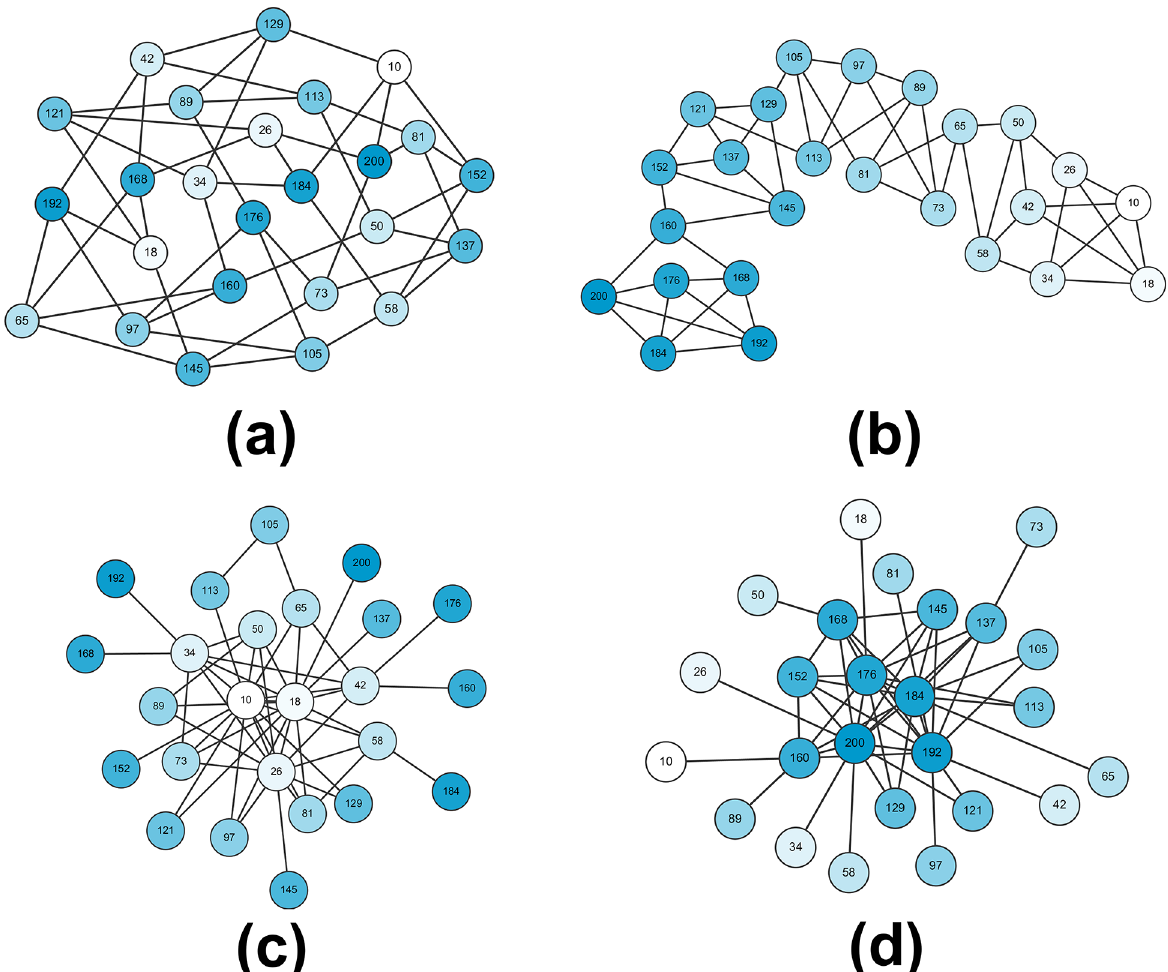
Fig 1. The four network topologies. (a) Lattice_Hetero: actors with discrepant income levels are linked in a lattice, where each node has the same number of ties. (b) Lattice_Homo: actors with similar income levels are linked in a lattice, where each node has the same number of ties. (c) SF_Negative: income levels and nodal degrees are negatively associated in a network where ties are unevenly distributed across nodes. (d) SF_Positive: income levels and nodal degrees are positively associated in a network where ties are unevenly distributed across nodes. Numbers within each node represent income levels. Darker colors refer to higher